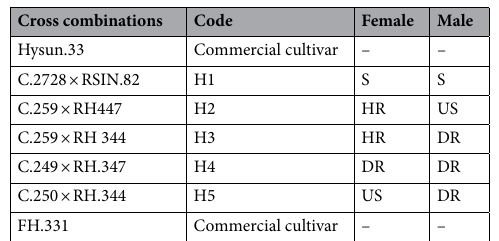
Table 6. Codes of evaluated sunflower hybrids for field validation of screening. HR = heat resistant, DR = drought resistant, S = susceptible, US =